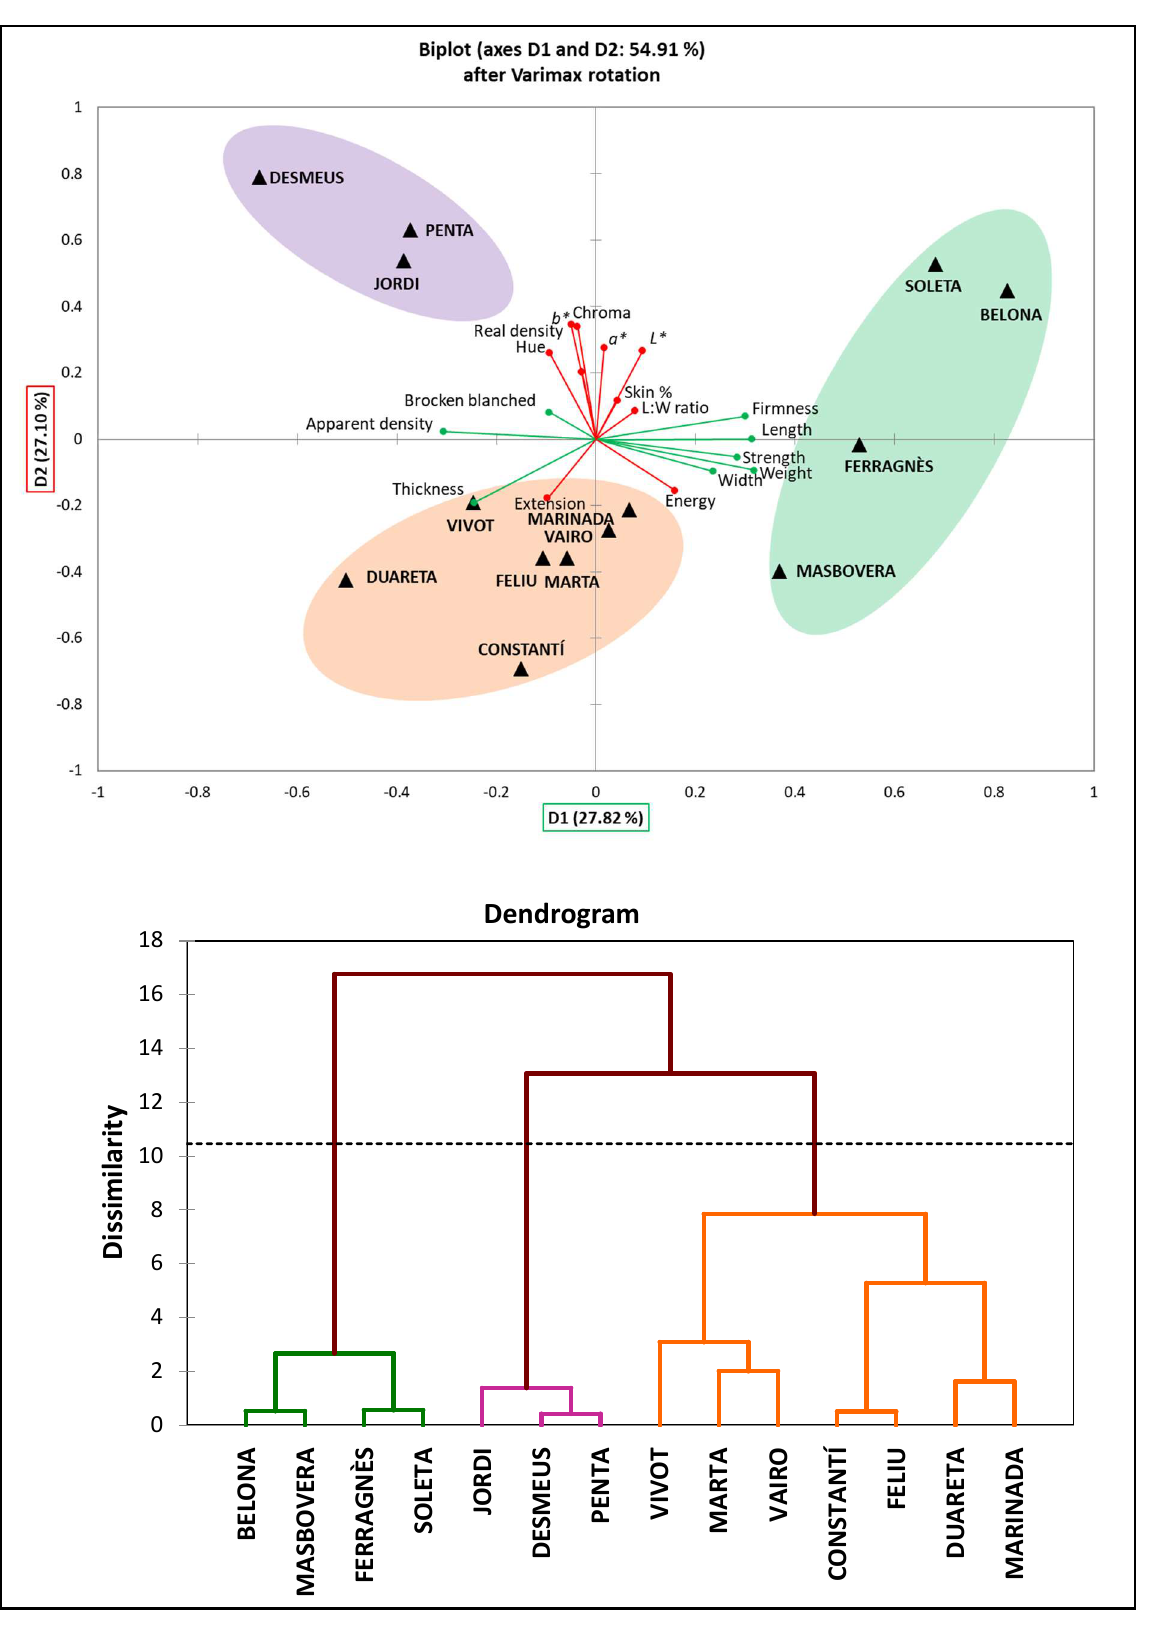
Figure 6. Principal Component Analysis (PCA) after Varimax rotation and Agglomerative Hierar- chical Clustering (AHC) on physical parameters of kernel.